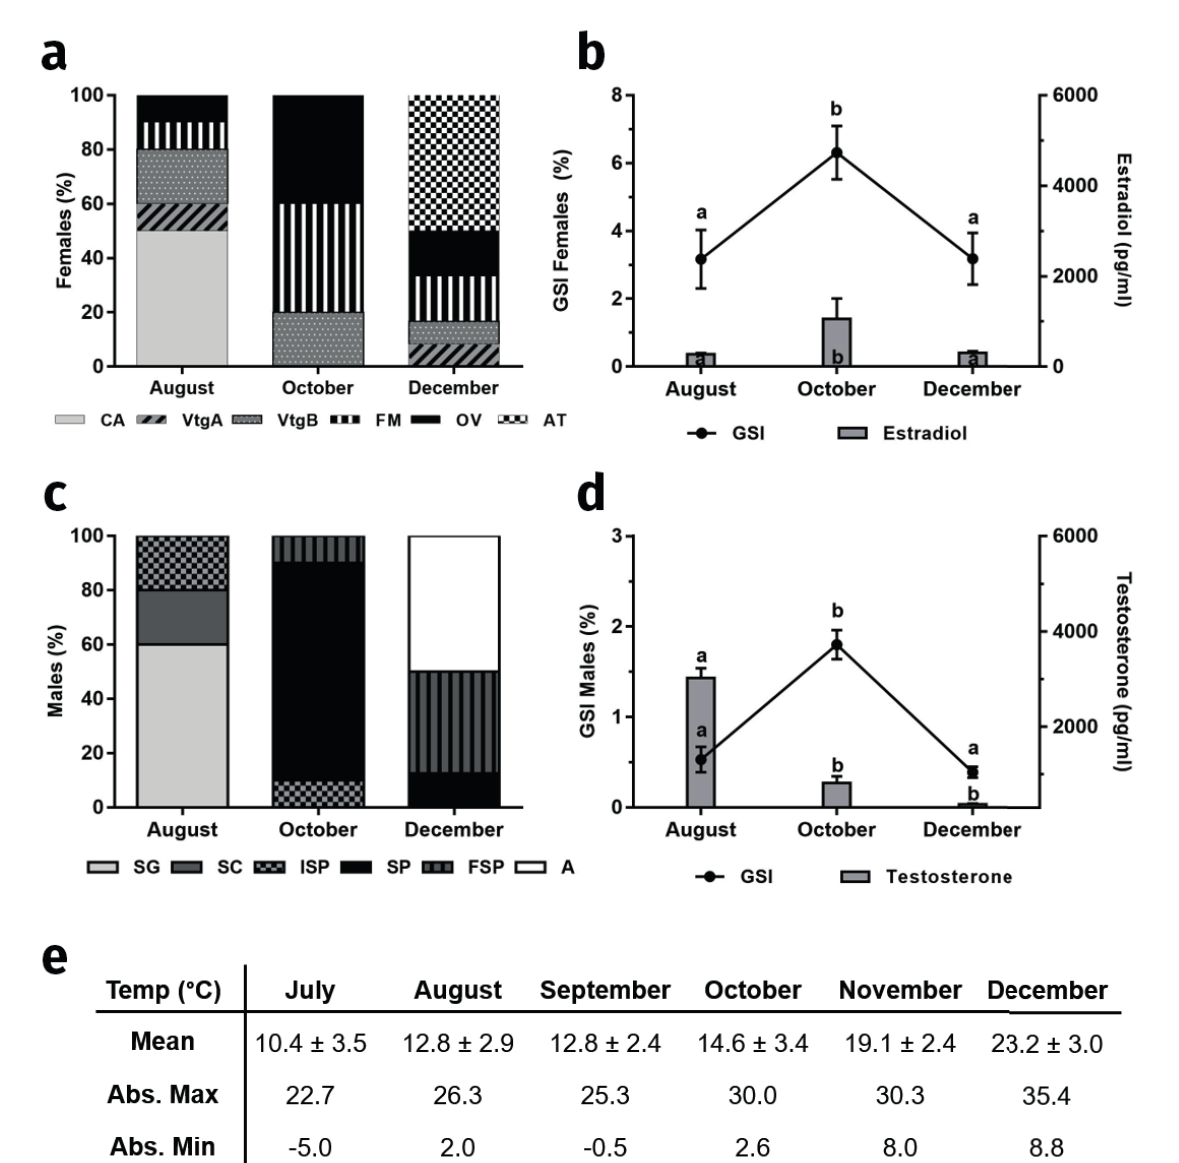
Figure 4. Pejerrey ( O. bonariensis ) sampling in Gómez lake (2015). a) Percentage of females at different gonadal stages. CA: cortical alveoli stage; VtgA: initial vitellogenesis stage; VtgB: advanced vitellogenesis stage; FM: fi nal maturation stage; OV: ovulated females; AT: atretic stage. b) Female gonadosomatic indexes (GSI: dots) and E plasma levels (bars). Values are mean ± SEM. Different letters represent signifi cant differences between sampling dates (Tukey’s multiple comparison test. p < 0.05). c) Percentage of males at different gonadal stages. ISP: Initial spermiogenic; SP: spermiogenic; FSP: fi nal spermiogenic; A: arrested. d) Male gonadosomatic indexes (GSI: dots) and T plasma levels (bars). Values are mean ± SEM. Different letters represent signifi cant differences between sampling dates (Tukey’s multiple comparison test. p < 0.05). e) Air temperature (°C) during the spawning season. Mean: Monthly mean temperature; Absolute Minimum; Abs. Max.: Absolute